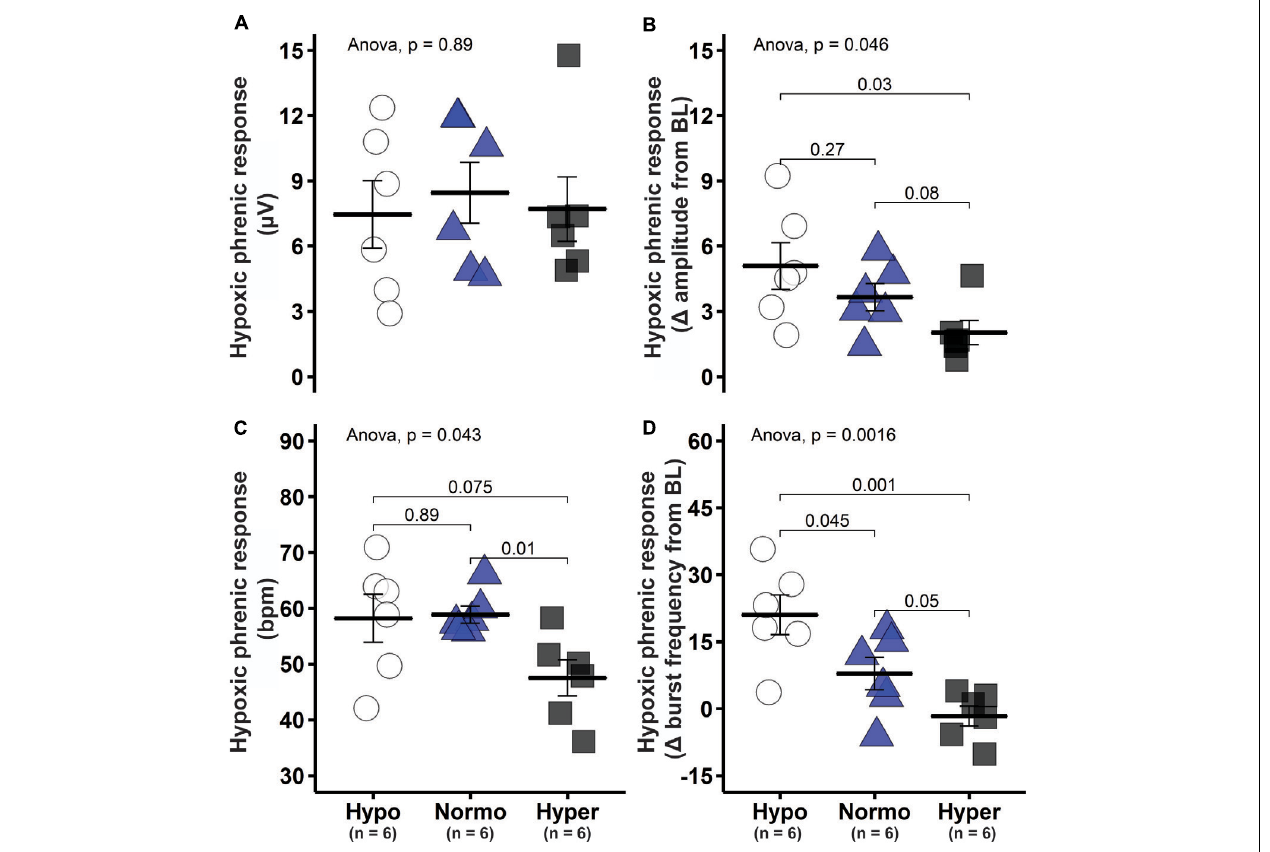
FIGURE 4 | Short-term hypoxic phrenic response was enhanced in the hypocapnic group. (A) Group average short-term hypoxic phrenic response in absolute burst amplitude values. (B) Group average short-term hypoxic phrenic response as delta burst amplitude from baseline. (C) Group average short-term hypoxic phrenic response in absolute burst frequency values. (D) Group average short-term hypoxic phrenic response as delta burst frequency from baseline. Data are presented as mean ± standard error of the